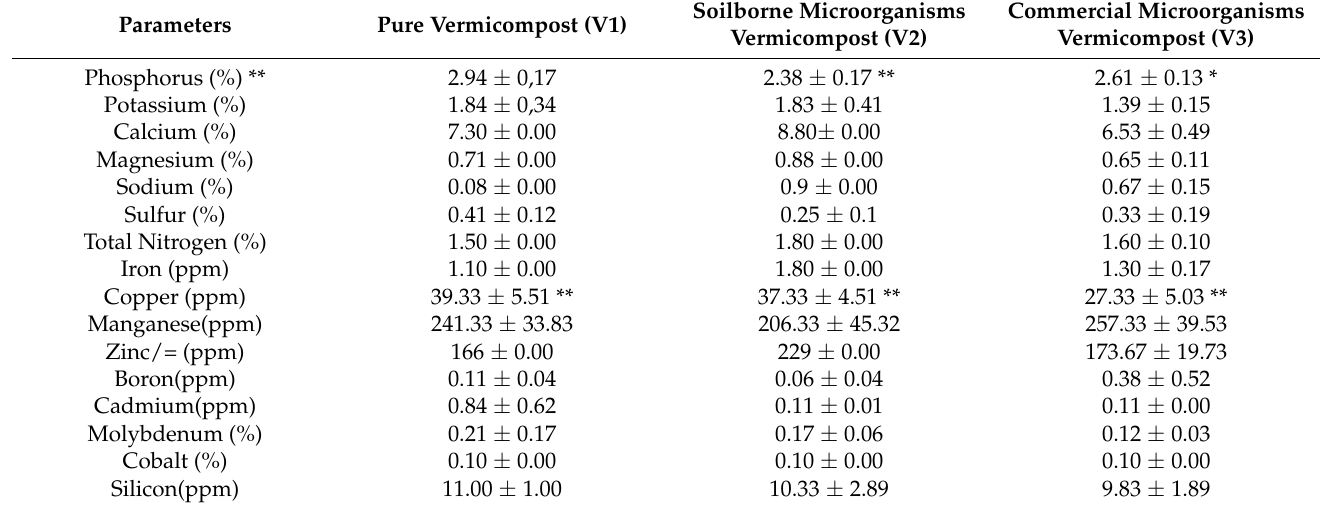
Table 3. Analysis of macro-and micronutrients evaluated in each treatment with three replicates (mean ± standard